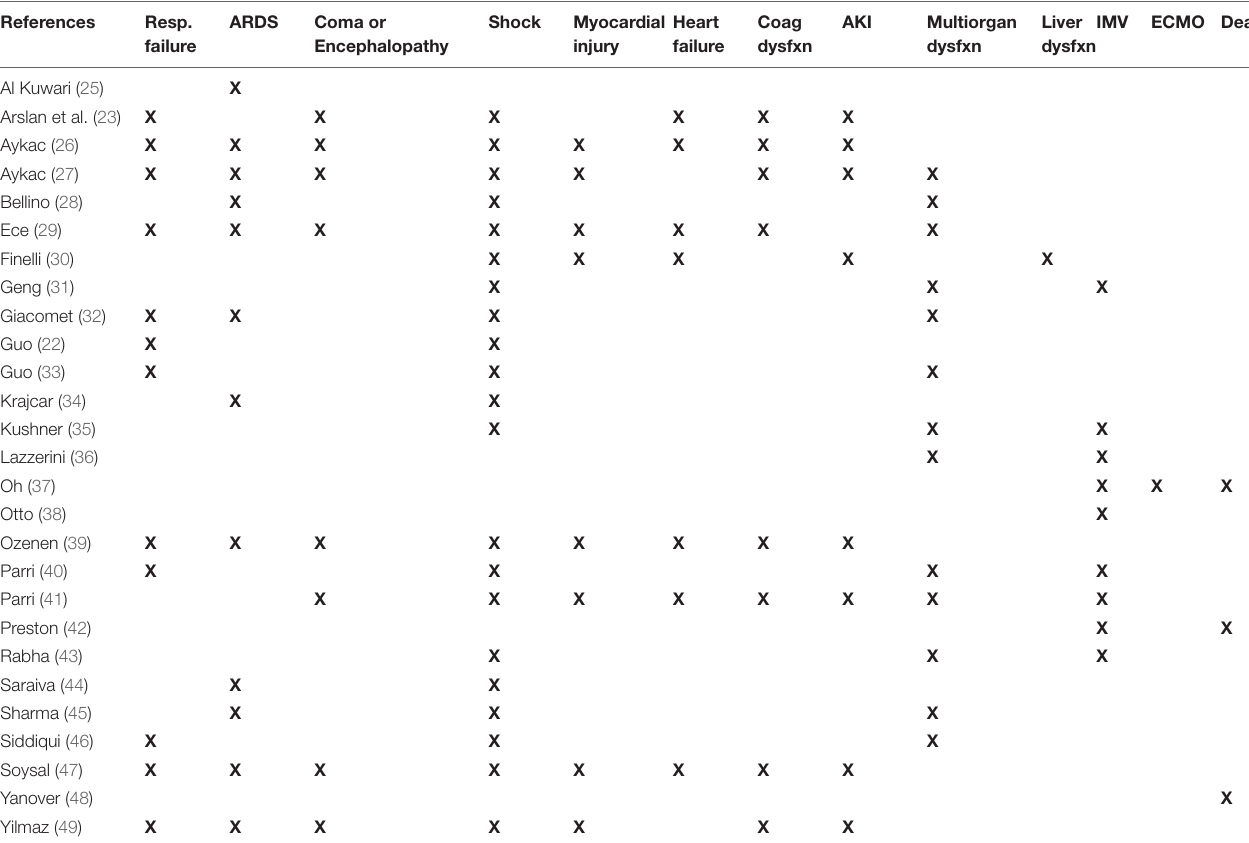
TABLE 1 | Definition of severe outcome in the analyzed